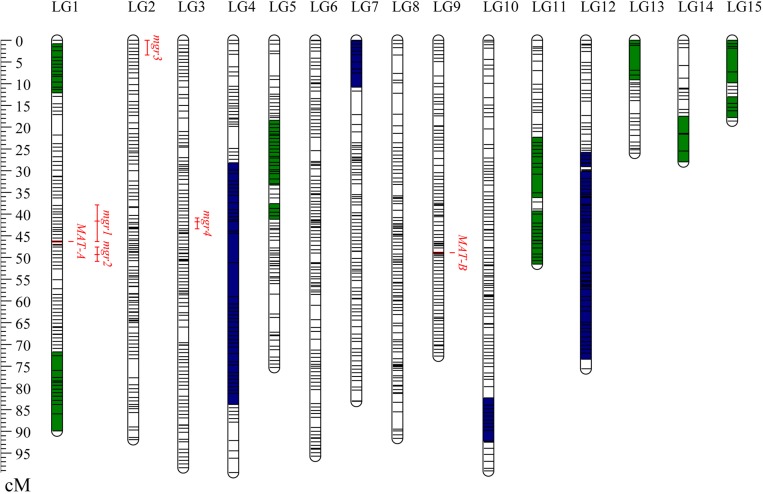
Distribution of bins on the genetic linkage map of Hericium erinaceus. The 15 LGs were randomly designated as LG1–LG15. Short lines in the LG bars indicate bin markers. The genetic position of bins is shown with a genetic ruler on the left. Segments in green representing the skewed bins in the segregation distortion regions are biased to CS-4, whereas segments in blue indicating the skewed bins are biased to 911-4. Four QTLs for mgr are shown on the right side of the LGs. The LOD-1 confidence interval is indicated by the length of the QTL bar, and the position of the LOD peak is represented by the short line in the middle of the QTL bar.